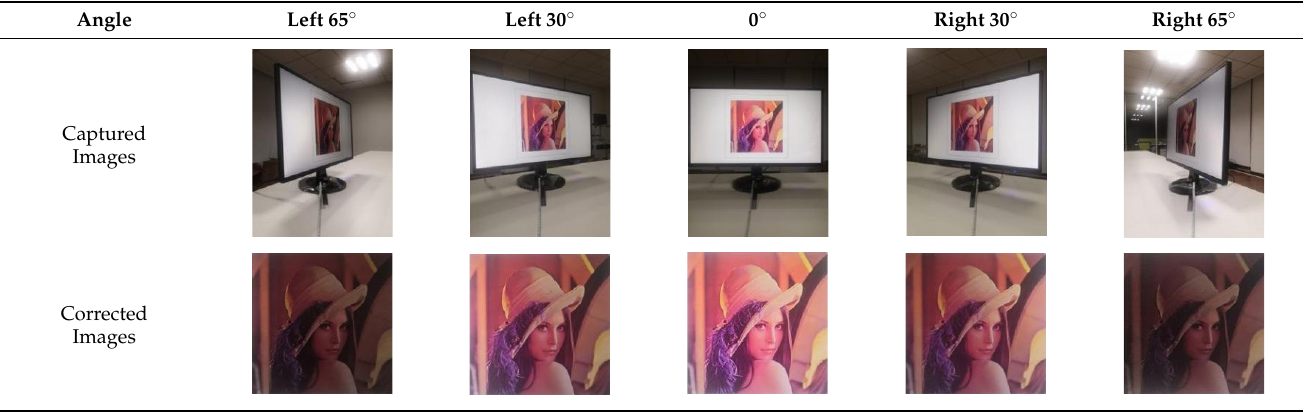
Table 6. Captured and corrected images at different horizontal